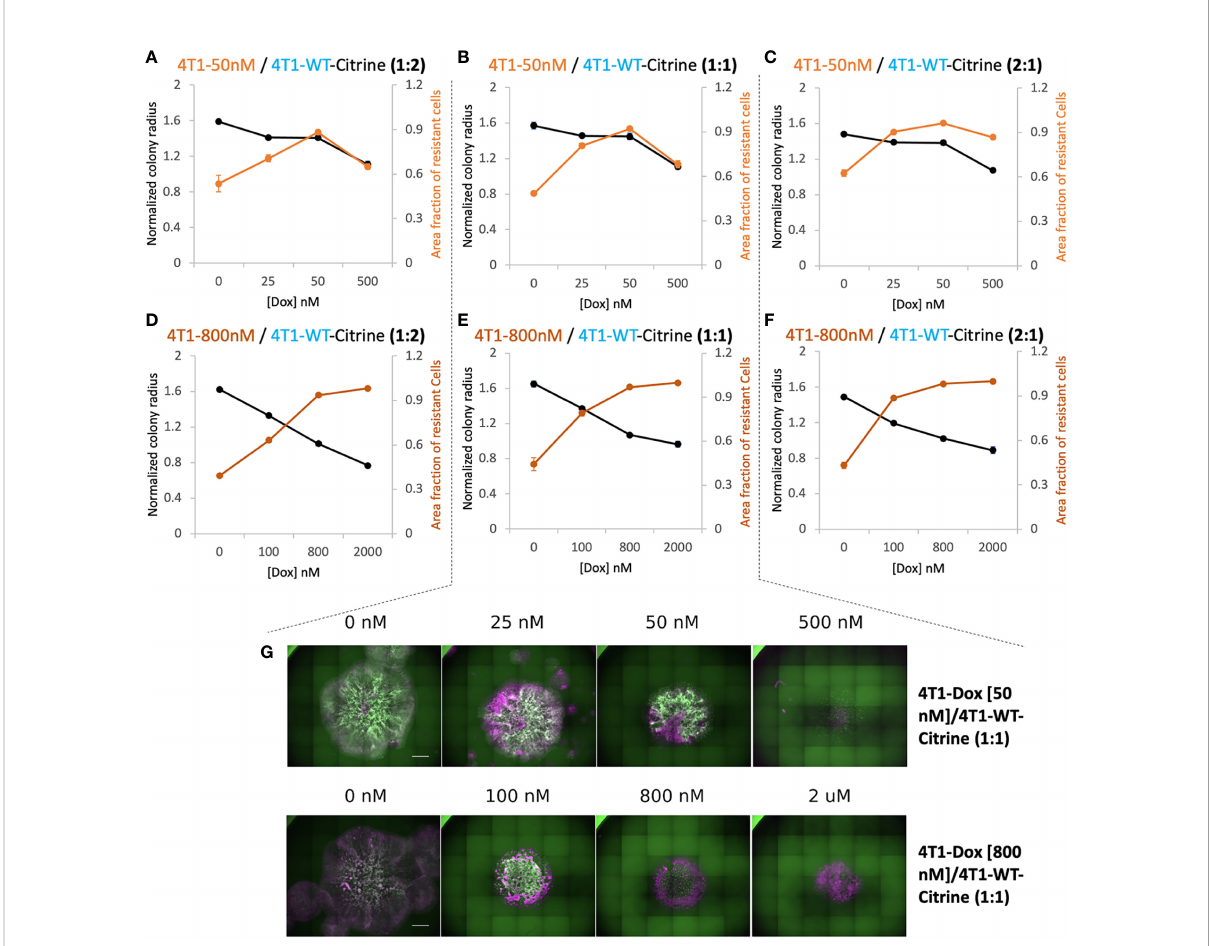
FIGURE 3 Relationship between overall 2D tumor colony size and treatment ef fi cacy. (A – C) Normalized radius (black) and Area fraction of resistant cells (red) for mixtures of chemosensitive 4T1 and 50 nM 4T1-Dox resistant cells at varied ratios. (D – F) Normalized radius (black) and Area fraction of resistant cells (red) for mixtures of chemosensitive 4T1 and 800 nM 4T1-Dox resistant cells at varied ratios. The fraction of resistant cells was calculated from area of the mixed colonies occupied where all cells were stained with Hoechst and doxorubicin-sensitive cells expressing Citrine. Resistant fractions = (Hoechst – Citrine)/Hoechst. (G) Stitched 4X fl uorescent images of colonies demonstrating the distribution of chemosensitive cells (4T1-WT, Citrine) in each colony (Hoechst) in the presence of doxorubicin. Colonies were formed by seeding 1:1 mixture of 4T1-WT and 50 nM resistant cells (top, corresponding to (B) or 1:1 mixture of 4T1-WT and 800 nM resistant cells (bottom, corresponding to (E) . Scale bar = 1000 m m. Number of replicates, n = 3 or 4, and the standard error is calculated with standard deviation divided by the square root of